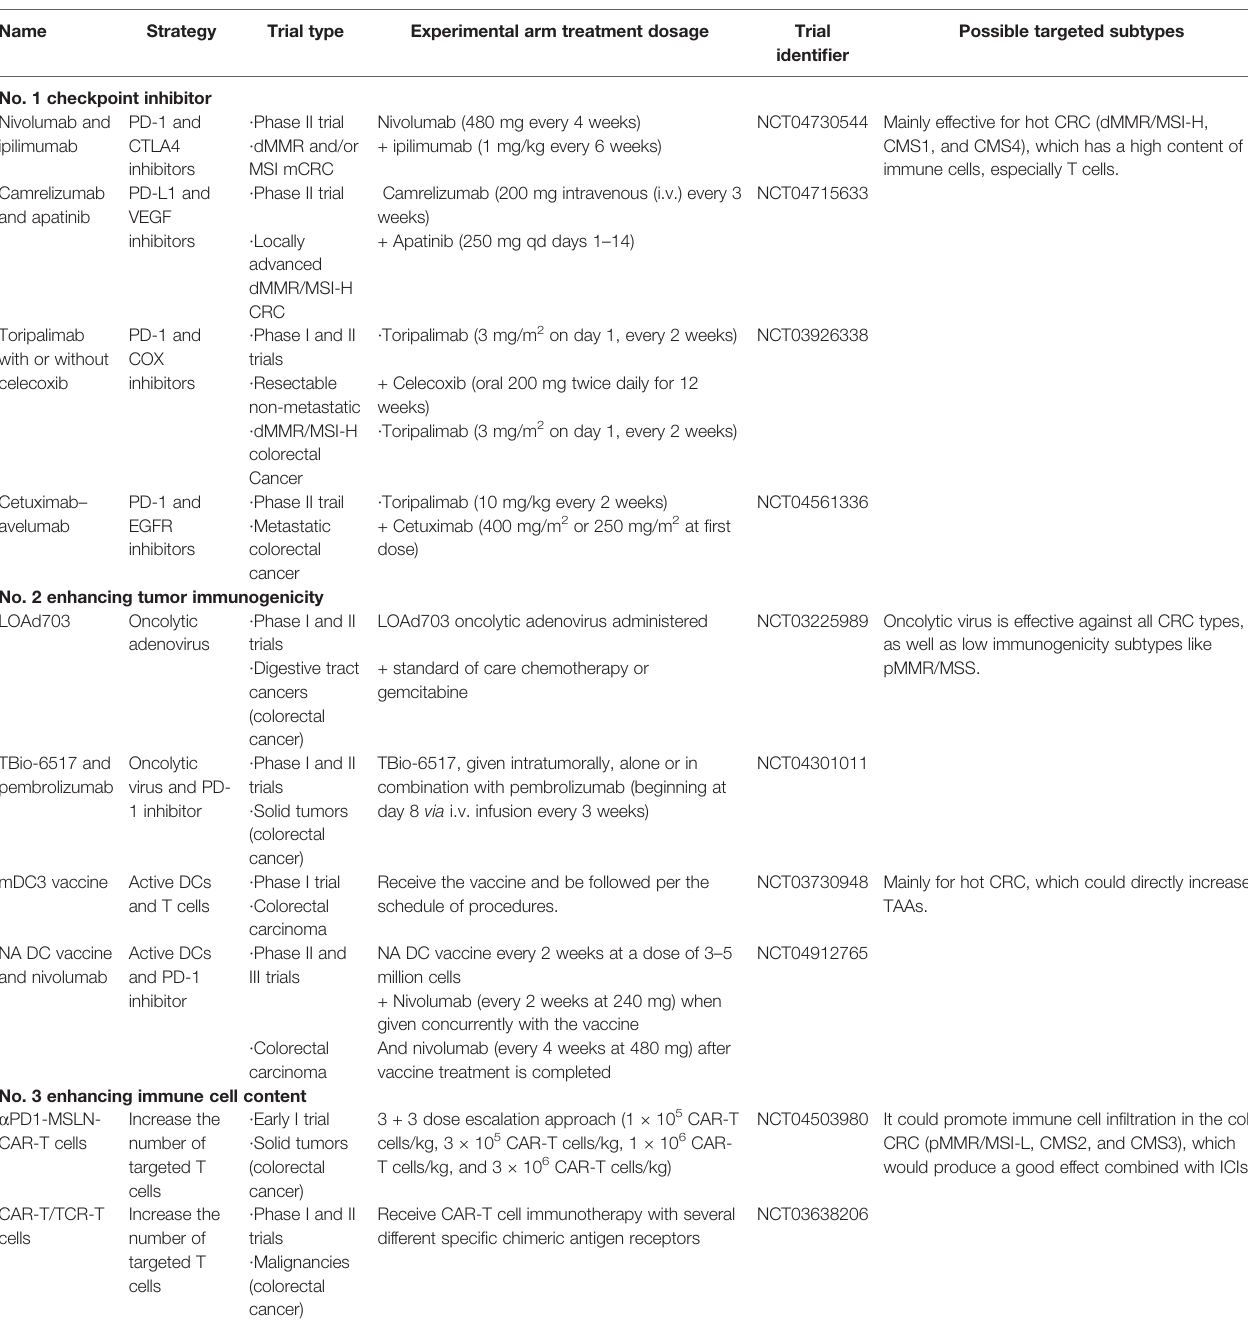
TABLE 1 | Ongoing clinical trials for immunotherapy in patients with CRC. Ongoing clinical trials for immunotherapy in CRC